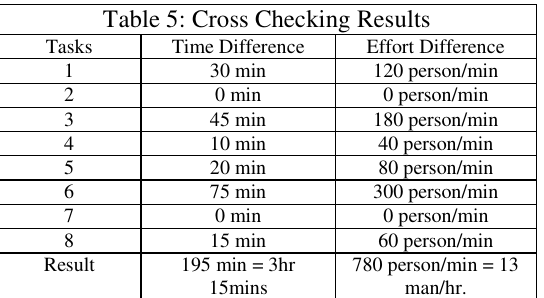
Table 5: Cross Checking